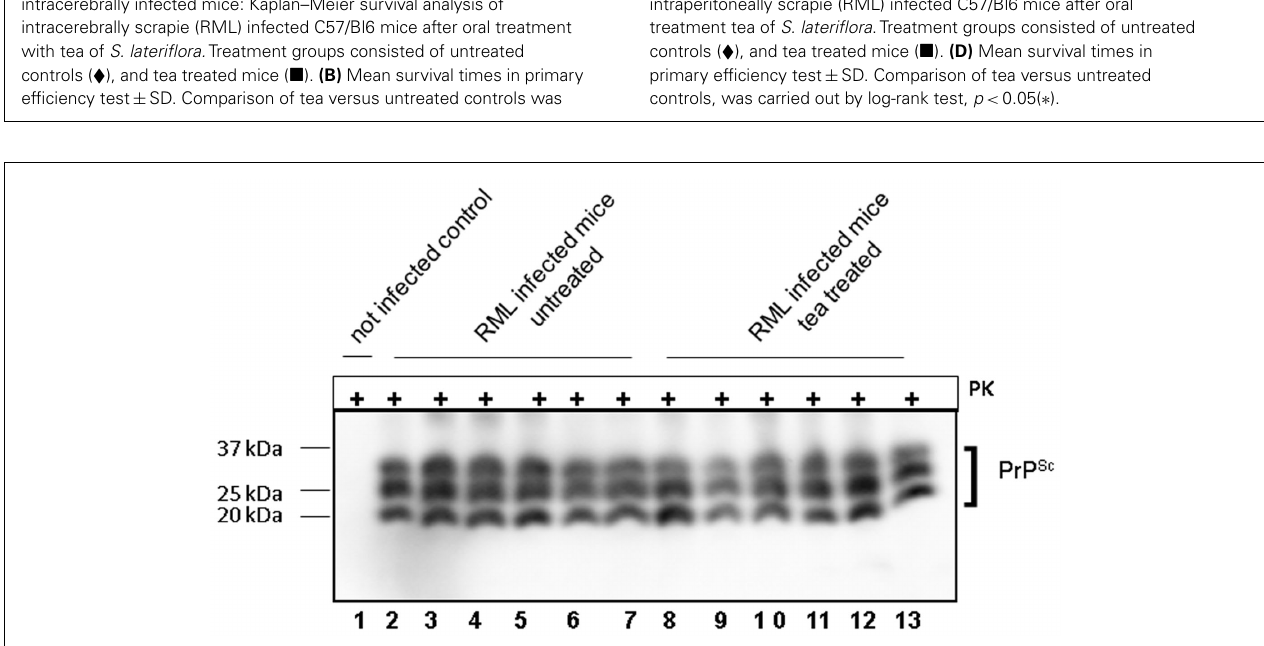
carried out by log-rank test, p < 0.01( ∗∗ ). (C) Oral treatment of intraperitoneally infected mice: Kaplan–Meier survival analysis of intraperitoneally scrapie (RML) infected C57/Bl6 mice after oral treatment tea of S. lateriflora .Treatment groups consisted of untreated controls ( (cid:2) ), and tea treated mice ( (cid:3) ). (D) Mean survival times in primary efficiency test ± SD. Comparison of tea versus untreated controls, was carried out by log-rank test, p < 0.05( ∗ ).